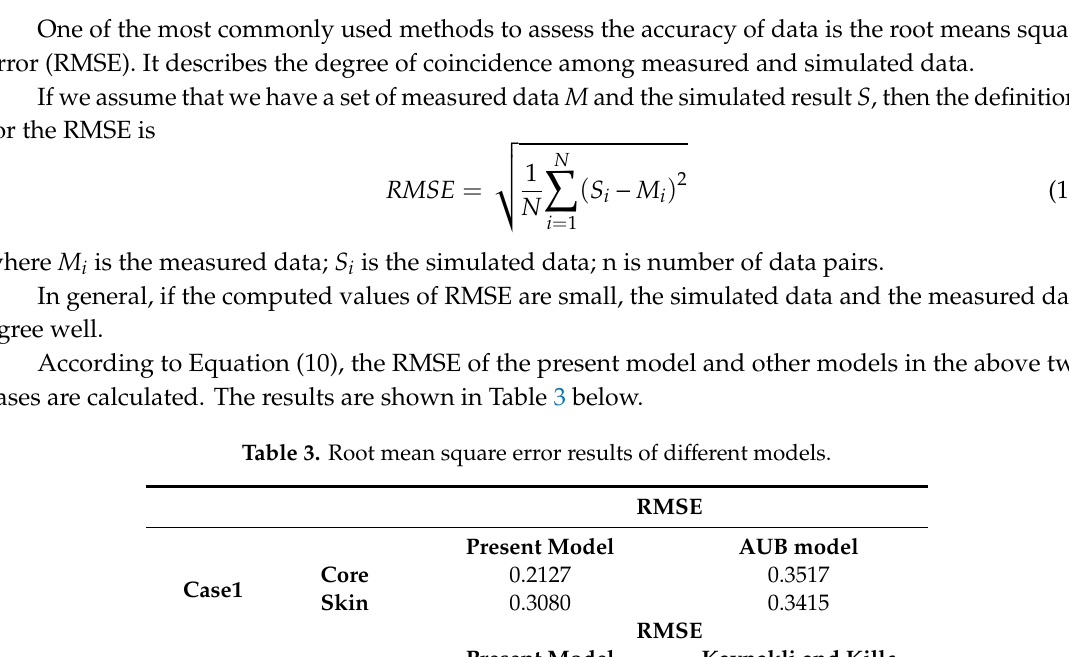
Figure 5. Comparison of the simulated results with the measured data [16], and Kaynakli and Kilic [25] as the ambient temperature step change.